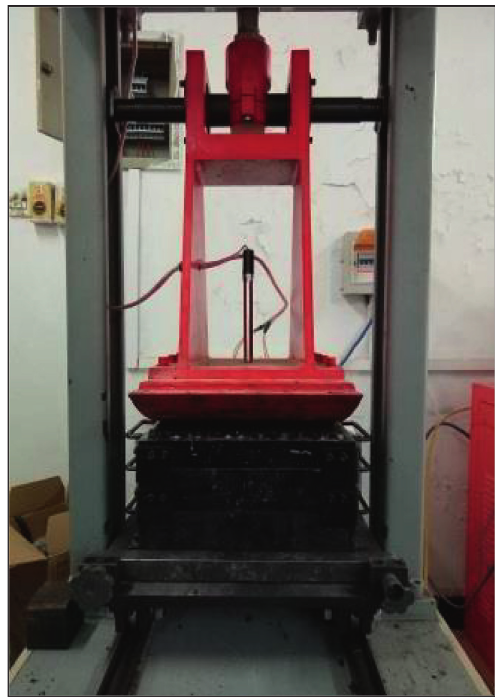
Figure 2: Production of upper-layer specimen.